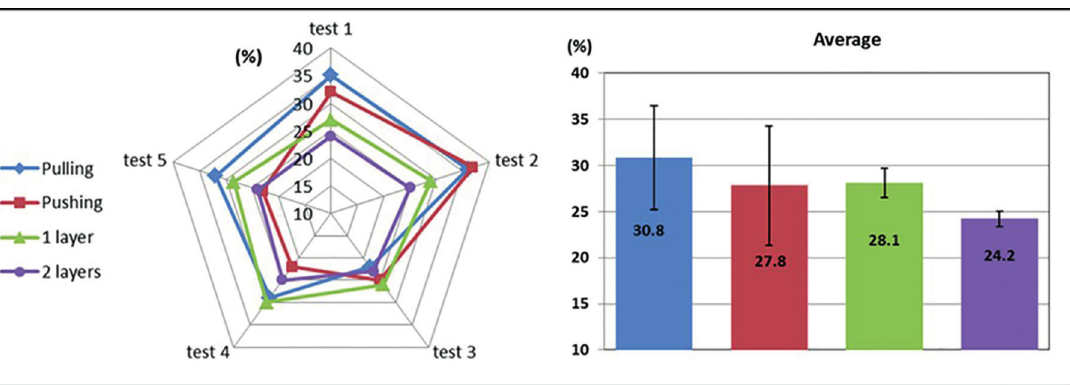
Figure 6: Dilution percentage of the samples calculated according to equation